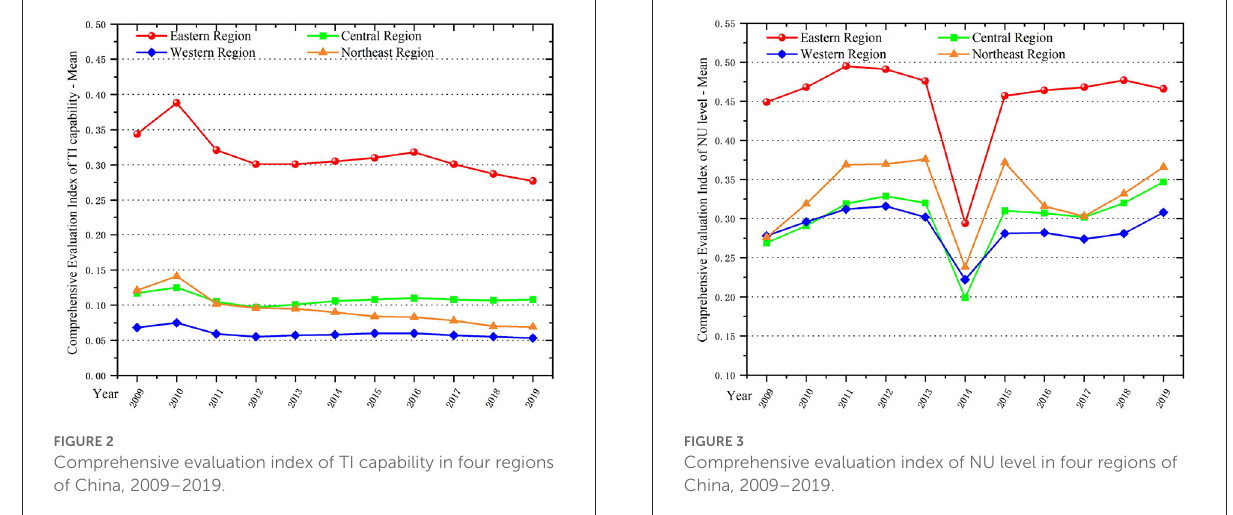
region of China covers most of the heavy industrial